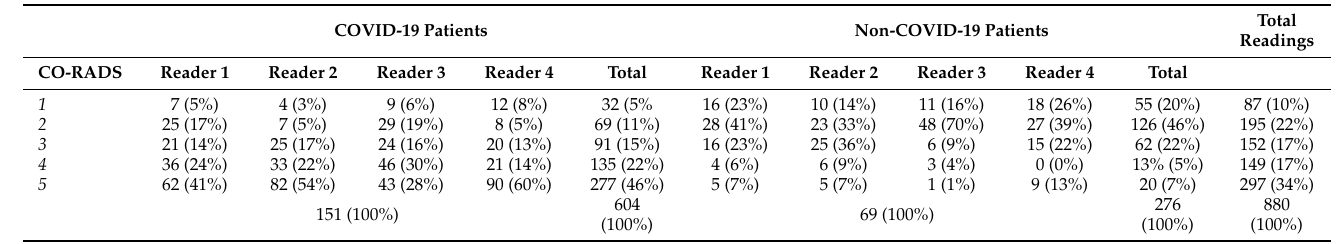
Table 2. CO-RADS scores assigned to COVID-19 and non-COVID-19 patients by the four readers. COVID-19